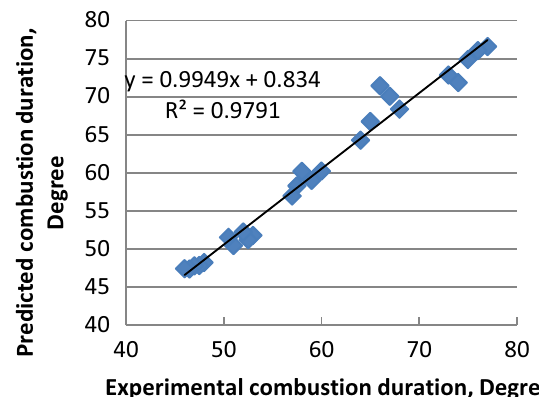
Figure 16. Correlation between ANN model and experimental values of peak cylinder pressure, ignition delay and combustion duration.